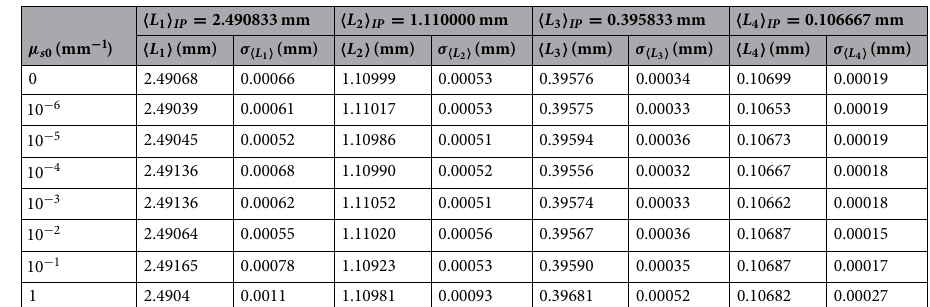
5 mm and internal radii 4, 3 and 2 Table 2. Data for a 4-layered non-absorbing sphere of external radius r = 1.75 and µ s 1.5 and µ s 0 ; in the second layer, r ( 4, 5 ) mm, n 1 ( 3, 4 ) mm, n 1 mm. In the first layer, r = = = ∈ ∈ 0 ; in the third layer, r 1.25 and µ s 1 µ s µ s 0 ; and in the forth layer r ( 2, 3 ) mm, n 1 ( 0, 2 ) mm, n 1 = = = = ∈ ∈ 0 . The refractive index of the external medium is 2. The results of MC simulations for several values and µ s = L k of µ s 0 are shown in table for the partial path length spent in the layers. The values predicted by IP are also (cid:31) (cid:30) 10 7 simulated trajectories. In the supplemental material a version of shown. The data in table pertain to N = L L this table showing the deviation between MC and IP is also reported. (cid:31) (cid:30) (cid:31) (cid:30)